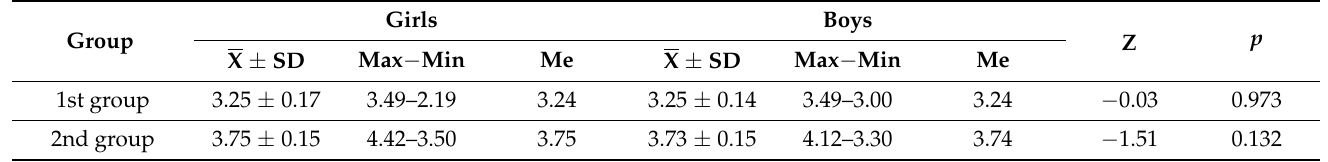
Table 1. The age of the study children, taking into account the half-year